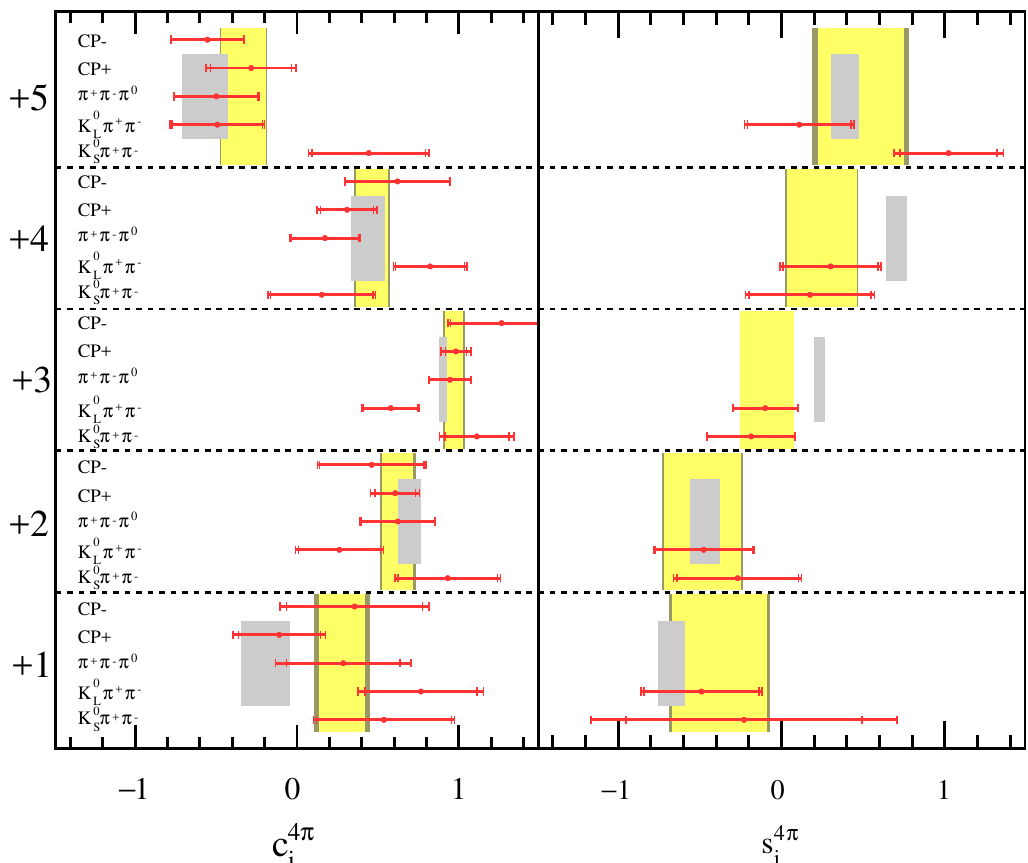
Figure 10 . Constraints on the c 4 (cid:25) and s 4 (cid:25) parameters using the optimal alternative binning scheme i i with N = 5, determined using di(cid:11)erent subsets of tags. The grey bands show the model predictions and uncertainties. The red lines show the measured values and uncertainties when using a single subset of tags | the inner error bar shows the statistical uncertainty, and the outer error bar shows the combined statistical and systematic uncertainty. The yellow band shows the combined result using all subsets of tags | the lighter shade of yellow represents the statistical uncertainty, and the darker shade of yellow shows the combined statistical and systematic